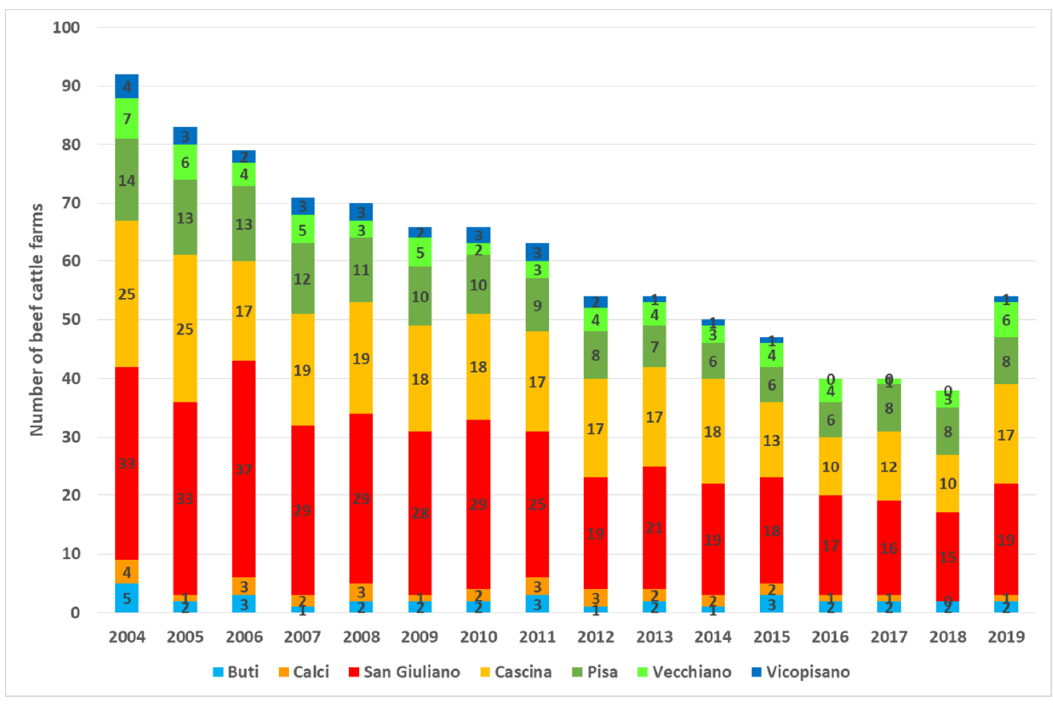
Figure 3. Short term dynamics of cattle farms in the Area Pisana municipalities (Italy). Source of the data: Istituto Zooprofilattico Sperimentale, 2020. Land 2020 , 9 , x FOR PEER REVIEW 10 of 21